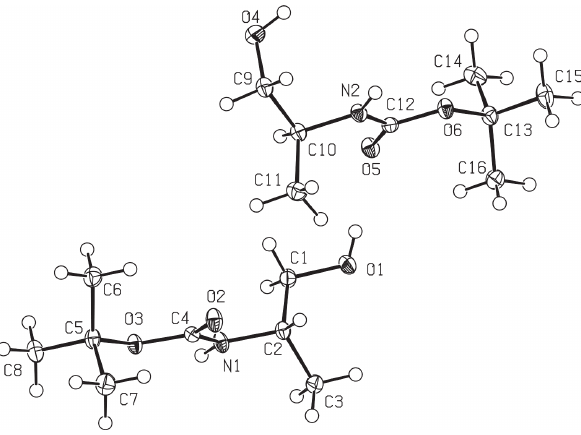
Table 2: Fractional atomic coordinates and isotropic or equivalent isotropic displacement parameters (Å 2